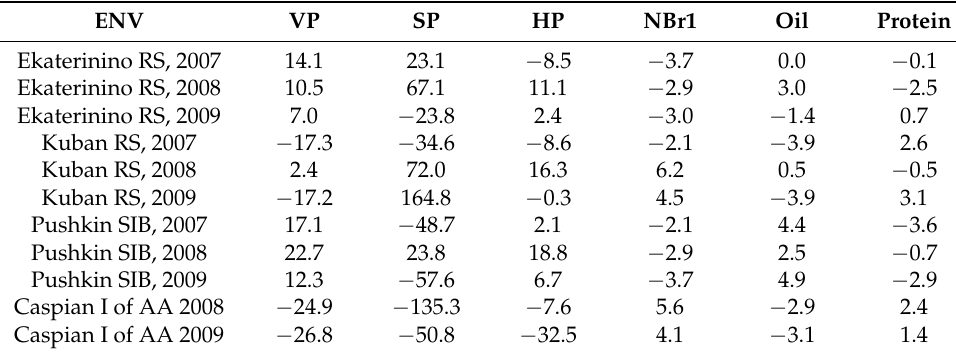
Table 3. Indices of the environment on the studied characters.